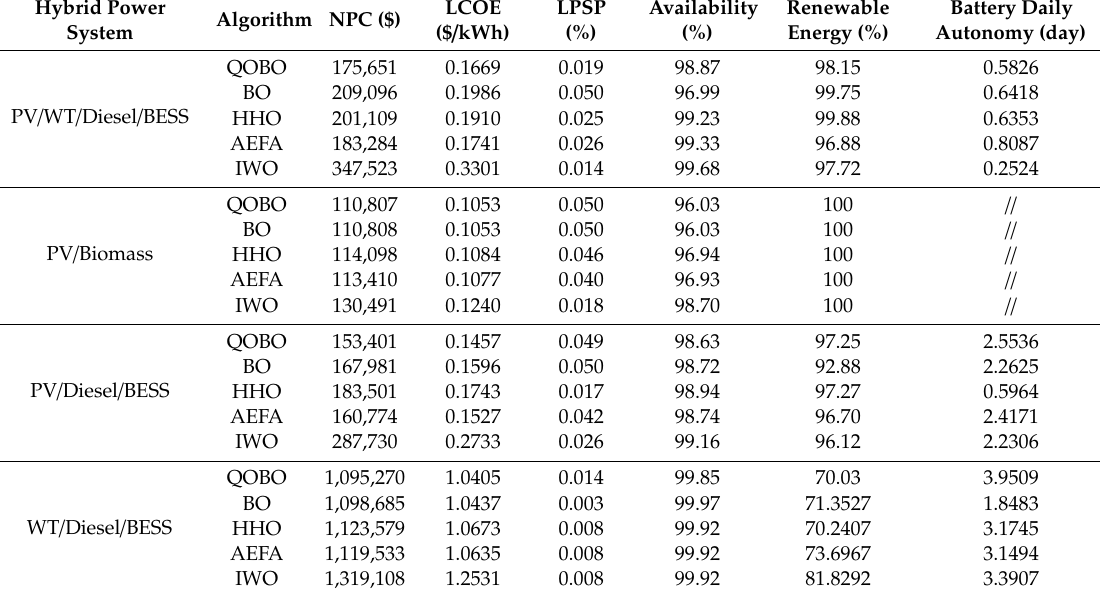
Table 3. Factor results for all